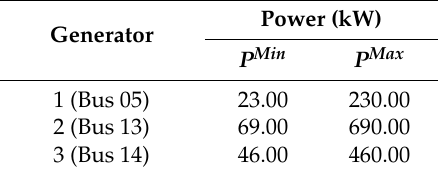
Figure 1. Grid under analysis. Table 1. Conventional generation features.